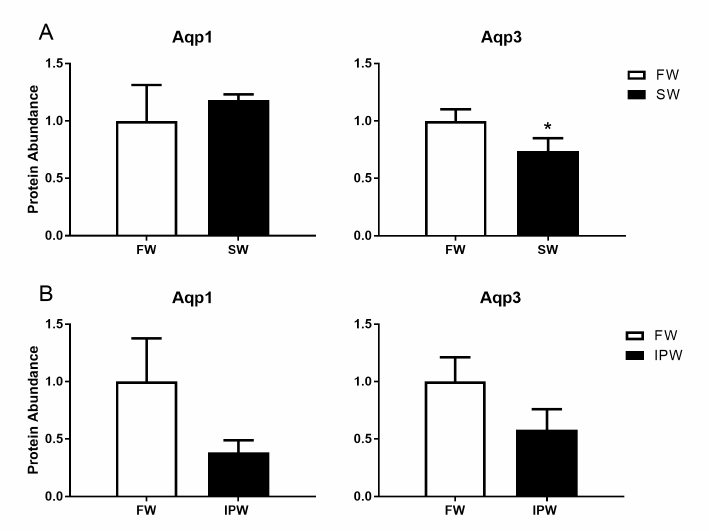
Figure 4. Western blot analysis of AQP1 (left) and AQP3 (right) protein levels in medaka gills 7 days after transfer from FW (open bars) to ( A ) SW (solid bars) or ( B ) IPW (solid bars). Immunoreactive AQP bands were analyzed and normalized to the level of β -actin in each sample. Values are presented relative to the FW control group. Statistically significant e ff ects (two-tailed Student’s t-tests, P < 0.05) are denoted by asterisks. Data are presented as mean ± standard error of the mean (n =